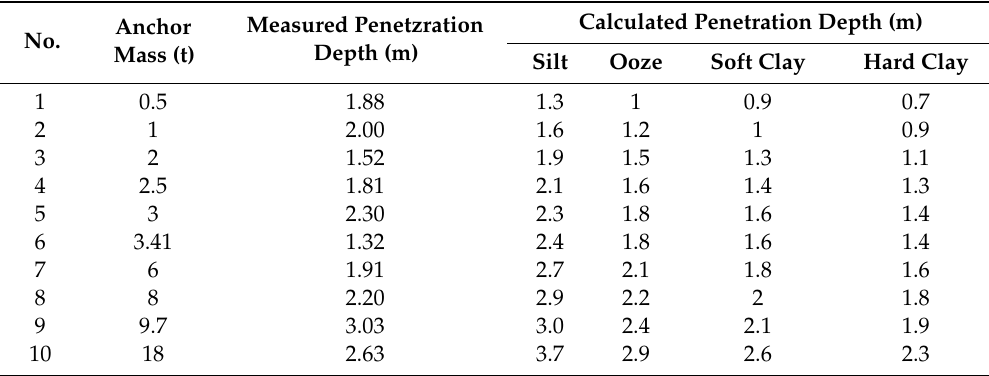
Table 5. Penetration depth of the anchor in clay